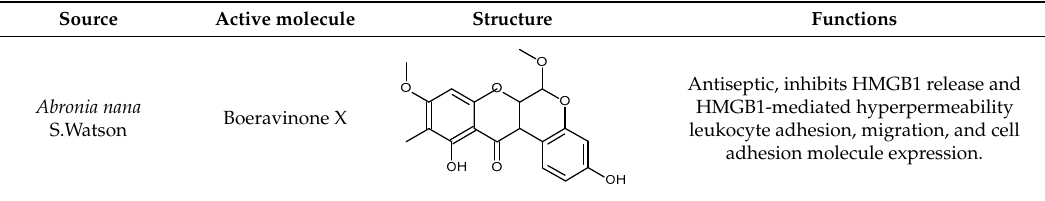
Table 1. Chemical structure of main active constituents in herbal extracts.